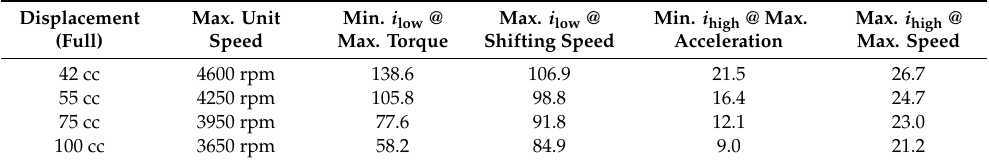
Table 3. HST Unit 2 selection lookup table